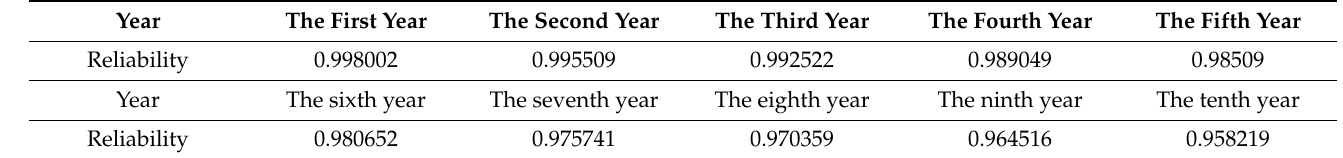
Table 10. Dynamic reliability of the smart meter after